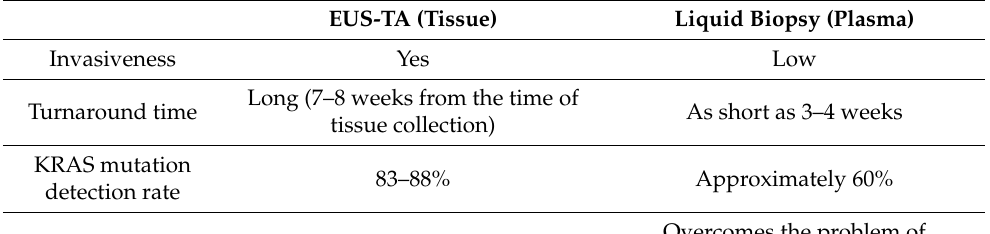
Table 2. Differences between EUS-TA and liquid biopsy panel analyses. EUS-TA (Tissue) Liquid Biopsy (Plasma) Invasiveness Yes Low Long (7–8 weeks from the time of As short as 3–4 weeks Turnaround time tissue collection) KRAS mutation 83–88% Approximately 60% detection rate Overcomes the problem of intra-tumor heterogeneity Applications in RNA, whole exon, Other advantages and whole genome analyses Application in the early detection of small residual lesions Results depend on the timing of specimen collection, tumor cell Difficulty in specimen collection, content cannot be evaluated risk of complications, in advance, Disadvantages specimen degradation over time, limited sensitivity in detecting and heterogeneity issues fusion genes and copy number, and within tumors uncertainty in determining